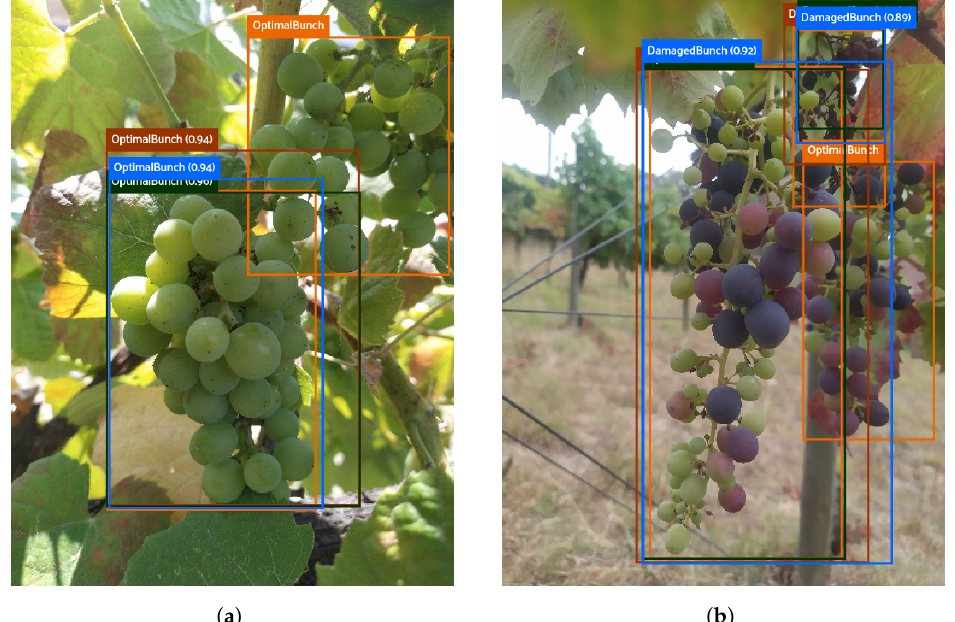
Figure 11. FNs on samples in the test set coincide across datasets. Orange bounding boxes present ground truth. Red bounding boxes present the predictions from YOLOv5. Green bounding boxes present the predictions from YOLOv7. Blue bounding boxes present the predictions from YOLOR. ( a ) Example 1. ( b ) Example